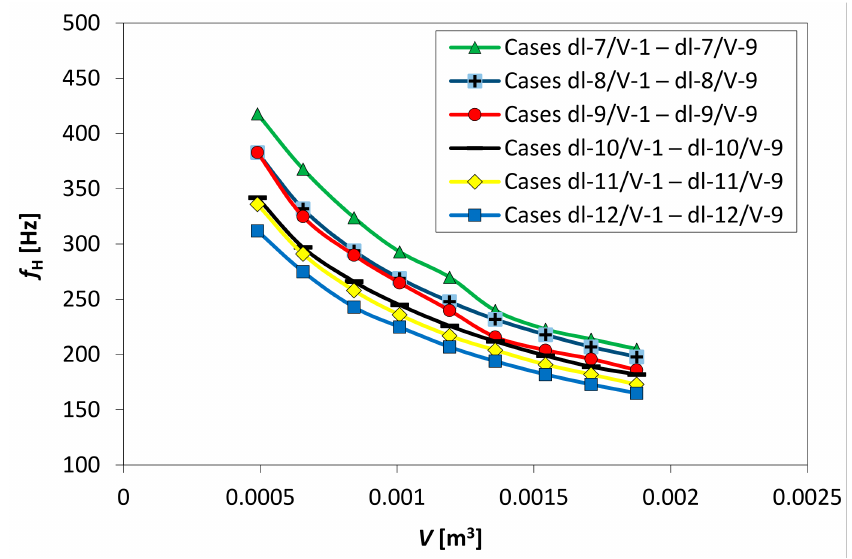
Figure 9. Effect of cavity volume and orifice length on the Helmholtz resonance frequency—the case of constant orifice